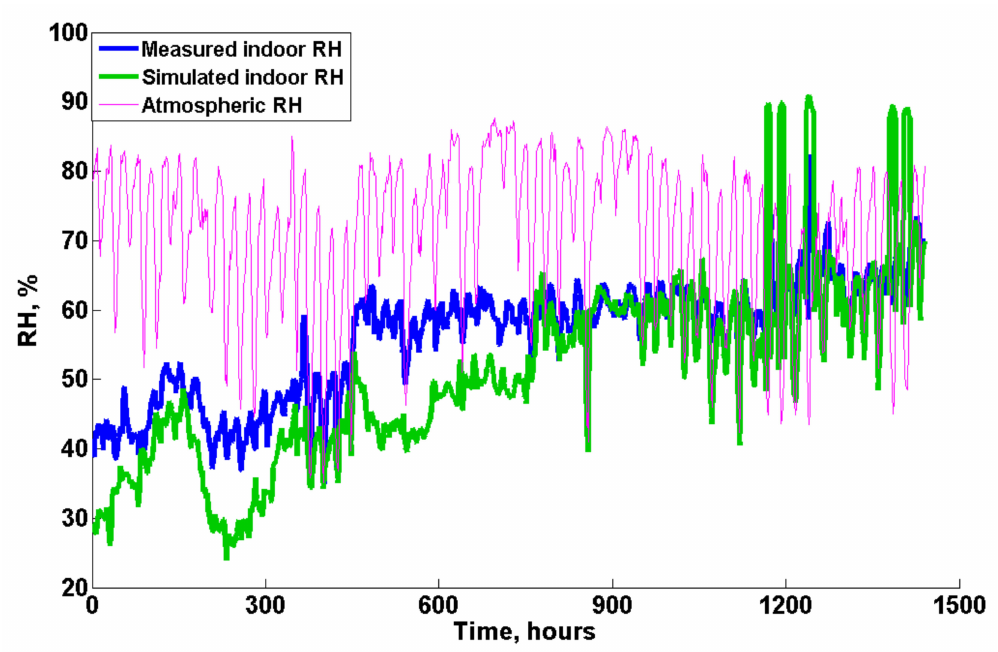
Figure 12. Relative humidity validation results.